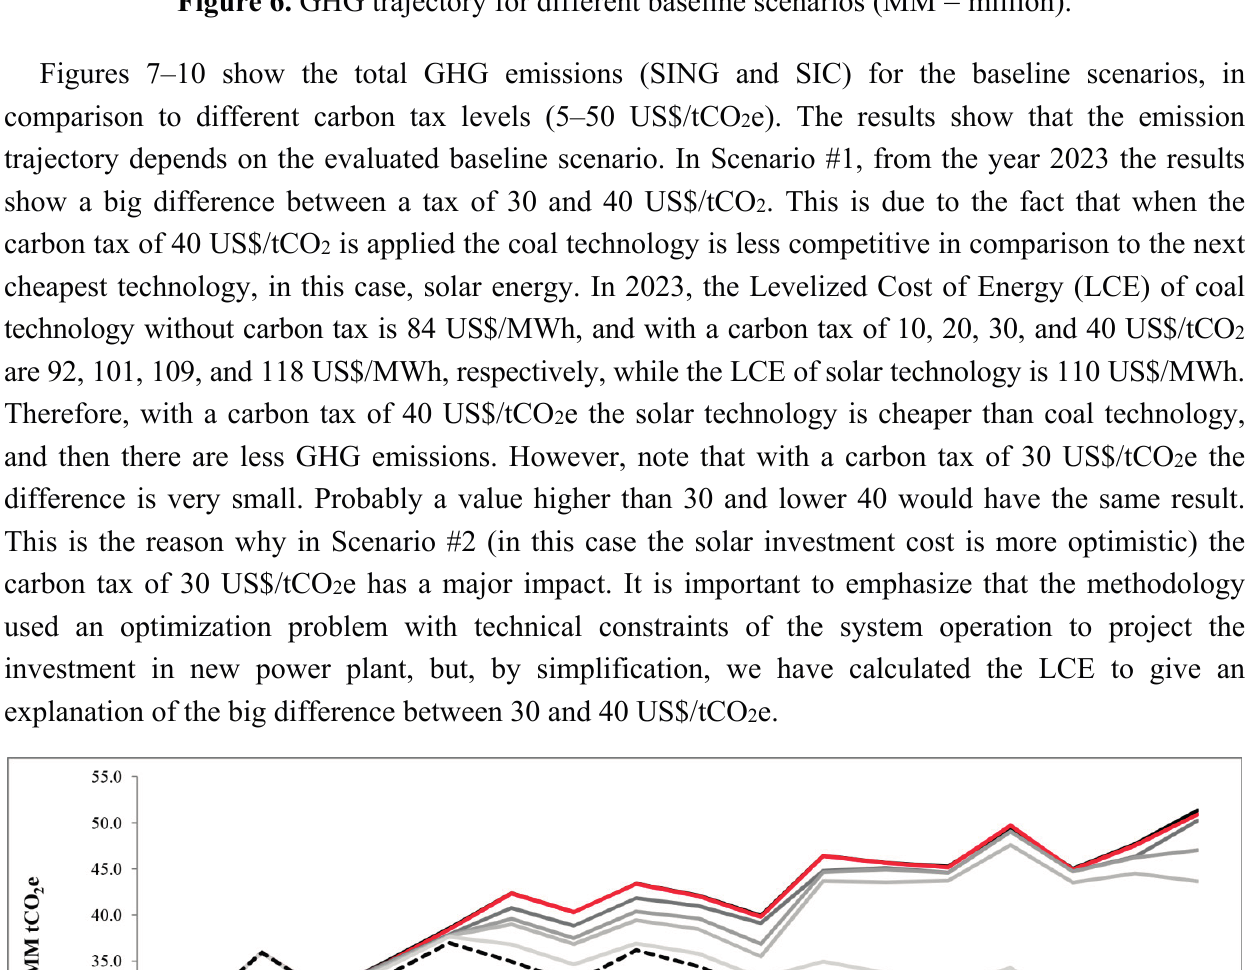
Figure 6. GHG trajectory for different baseline scenarios (MM = million).